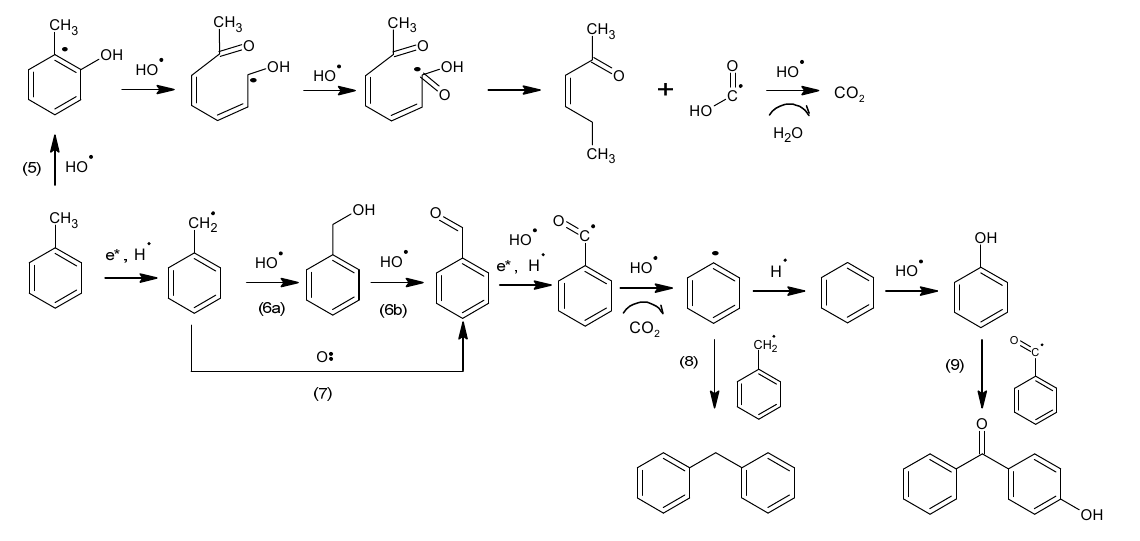
Figure 6. Possible reactions of toluene in plasma–catalytic system. For each catalyst, a similar gas composition was observed after the process. In the outlet gas, trace amounts of C2 hydrocarbons were formed. The concentration of hydrogen was lowered mainly due to the methanation process and hydrogenation of toluene decomposition products. In the presence of plasma or excited molecules, CO 2 could decompose to CO and oxygen or oxide radicals [21], which then reacted with